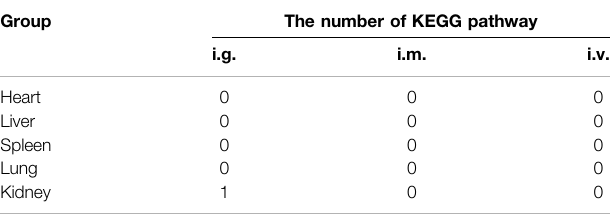
TABLE 4| The number ofKEGG pathway oftissues(heart, liver, spleen, lung, and kidneys) from the mice exposed by the intragastric (i.g.) administration, intramuscular (i.m.) injection, and intravenous (i.v.) injection. (adjust p value < 0.05, # of unique gene > 1).